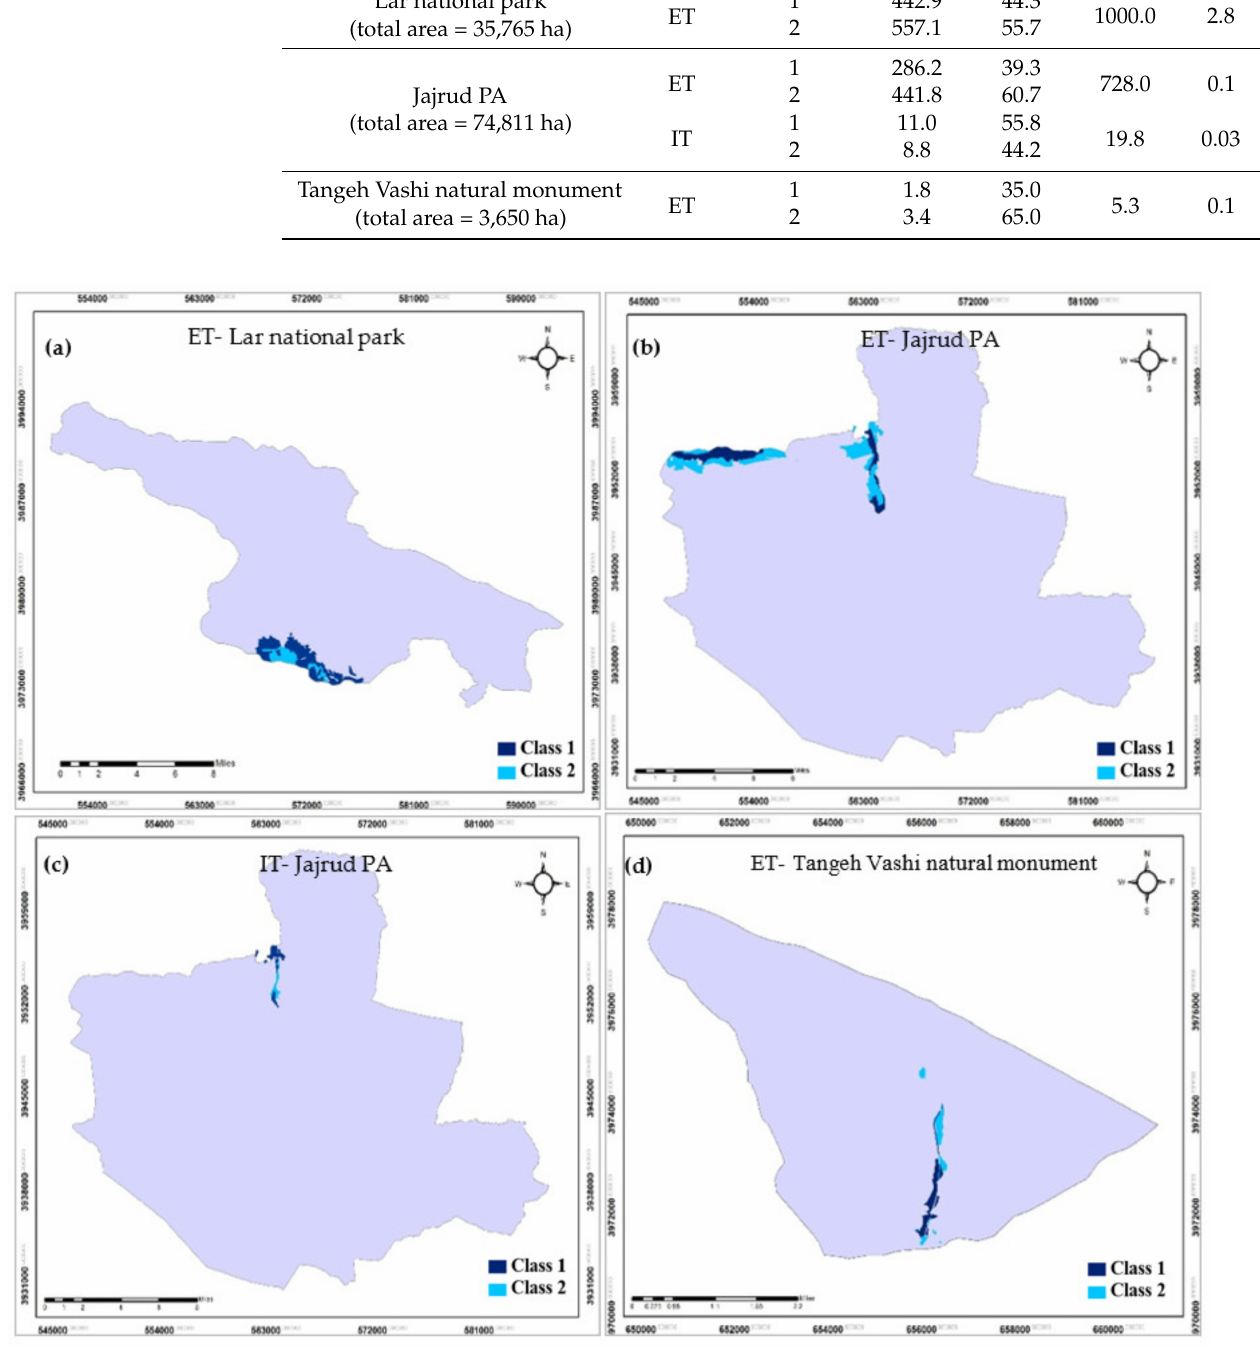
Figure 4. ET and IT maps in the studied areas; ( a ) Lar, ( b ) and ( c ) Jajrud, ( d ) Tangeh